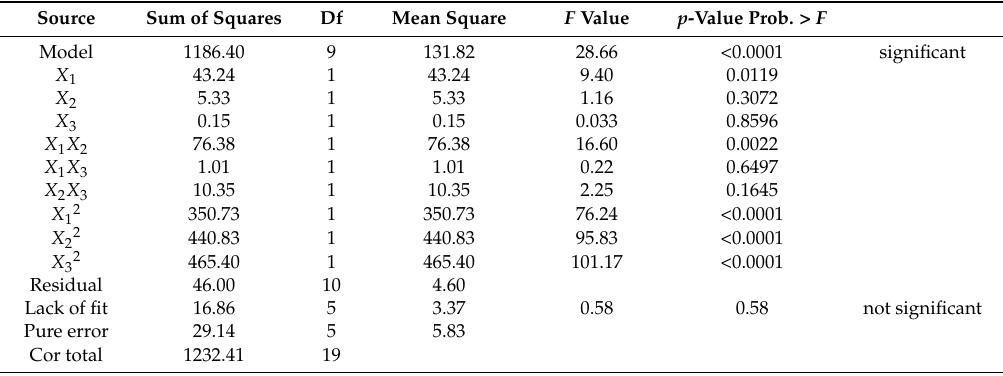
Table 2. ANOVA of the regression model for the response variables (EE) and independent variables ( X 1 , X 2 , X 3 ).